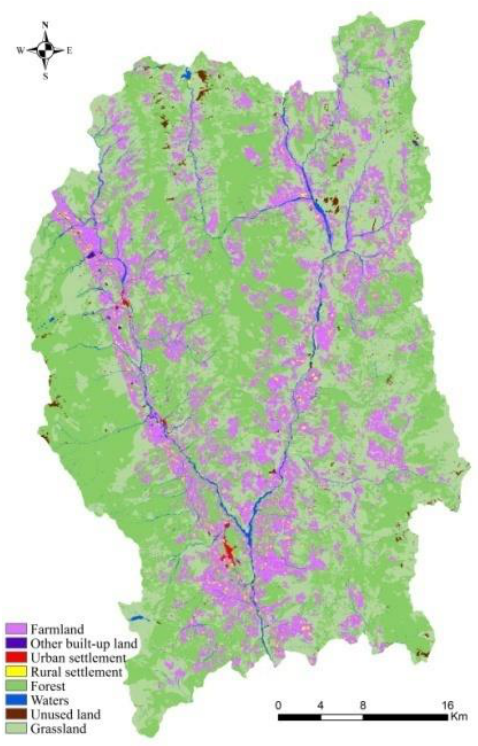
Figure 9. Simulated distribution map of land use in Puge County in 2017.